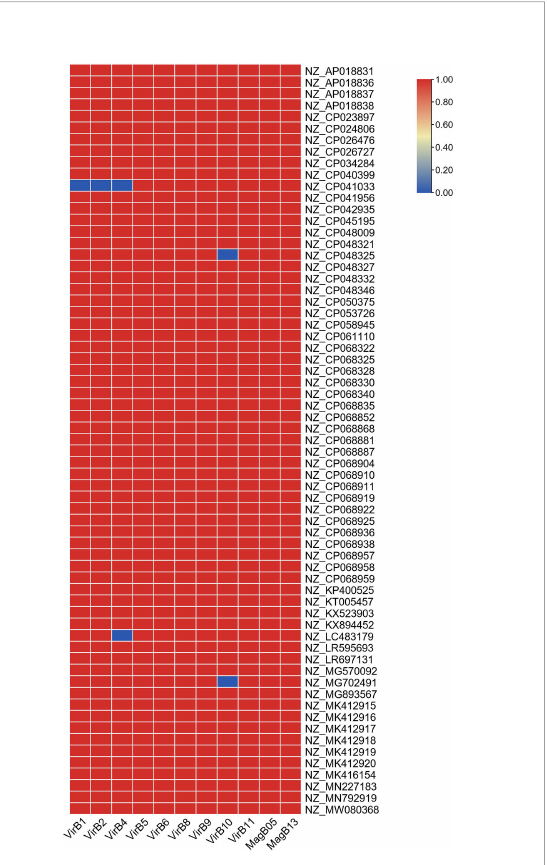
FIGURE 3 Details of the VirB-like T4SS gene clusters in the 66 bla OXA-181 - positive IncX3 plasmids in Enterobacterales . Red/blue colors indicate gene